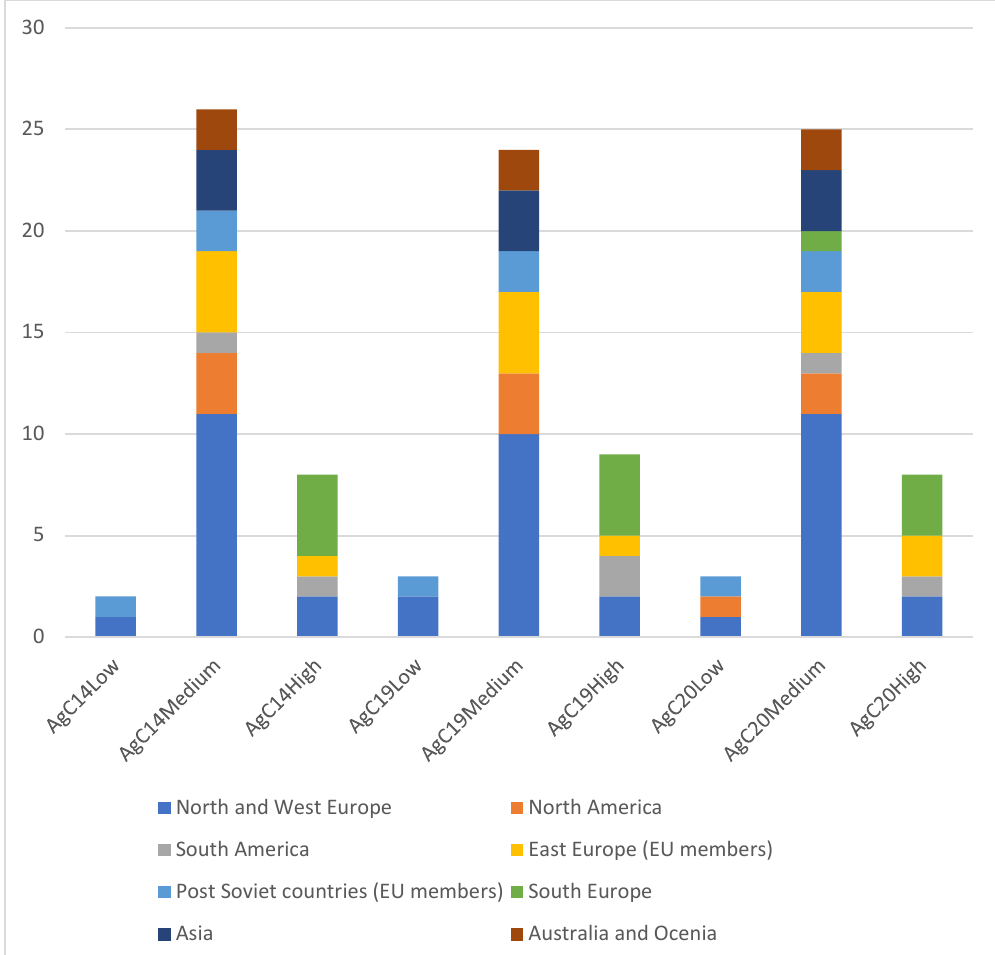
Figure 1. Distribution of the composite indicator by region (Source: own research, 2022).